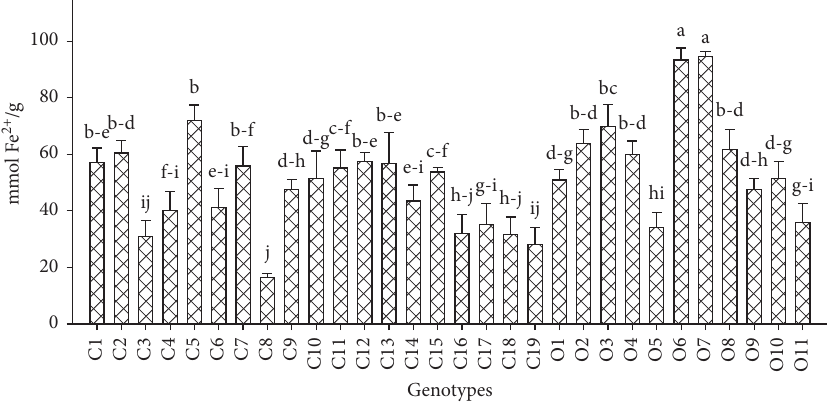
Genotypes Figure 6: Variation of FRAP (ferric reducing antioxidant